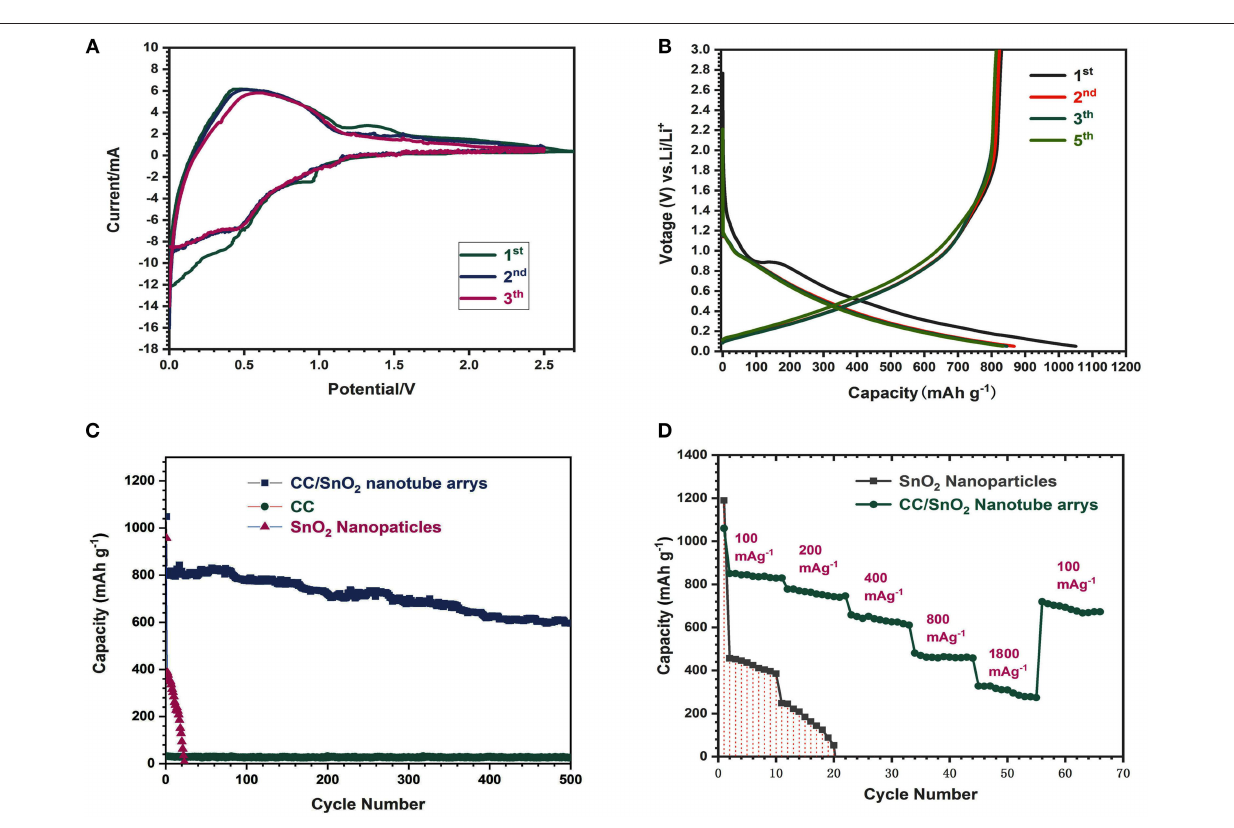
FIGURE 6 | (A) CV curves of CC/SnO 2 nanotube arrays. (B) Charge-discharge voltage profiles of CC/SnO 2 nanotube arrays at a constant current rate of 200 mAg − 1 . (C) Cycling performances of CC/SnO 2 nanotube arrays, SnO 2 nanoparticles, and pure CC at a constant current rate of 200mA g − 1 . (D) Rate performances of CC/SnO 2 nanotube arrays as well as SnO 2